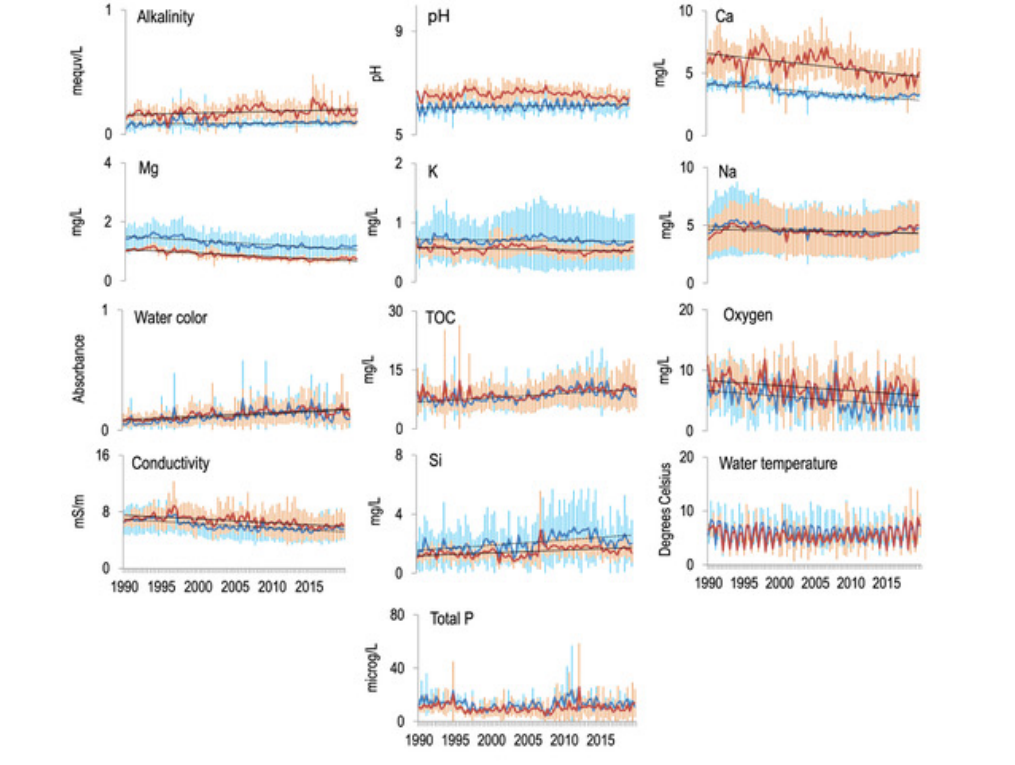
Fig. 1 . Temporal patterns of physicochemical variables in reference lakes (blue lines) and limed lakes (red lines). Trend lines (full, limed lakes; dashed, reference lakes) indicate significant components of monotonic change revealed by Kendall tau correlation analysis. Shown are means ± standard